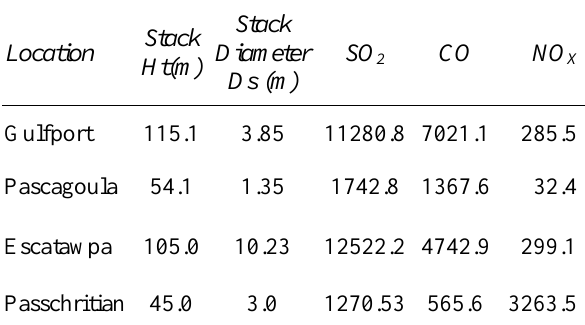
Table 2 : Sources of elevated release considered for the Hysplit computations